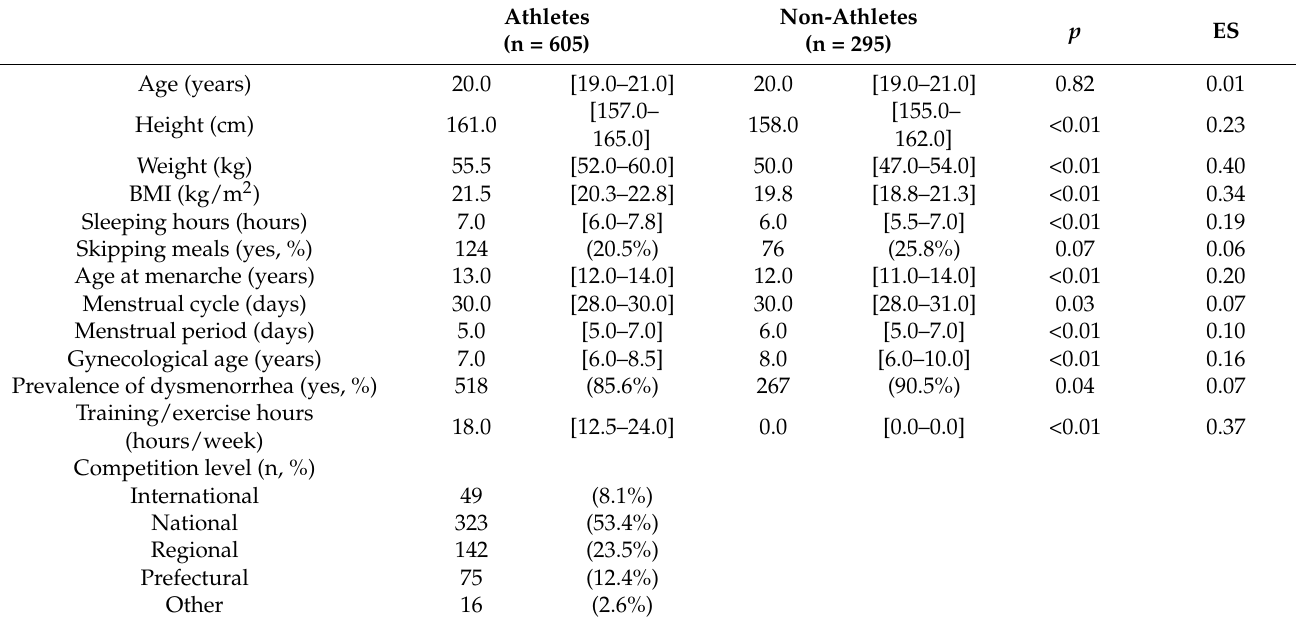
Table 1. The characteristics of the study